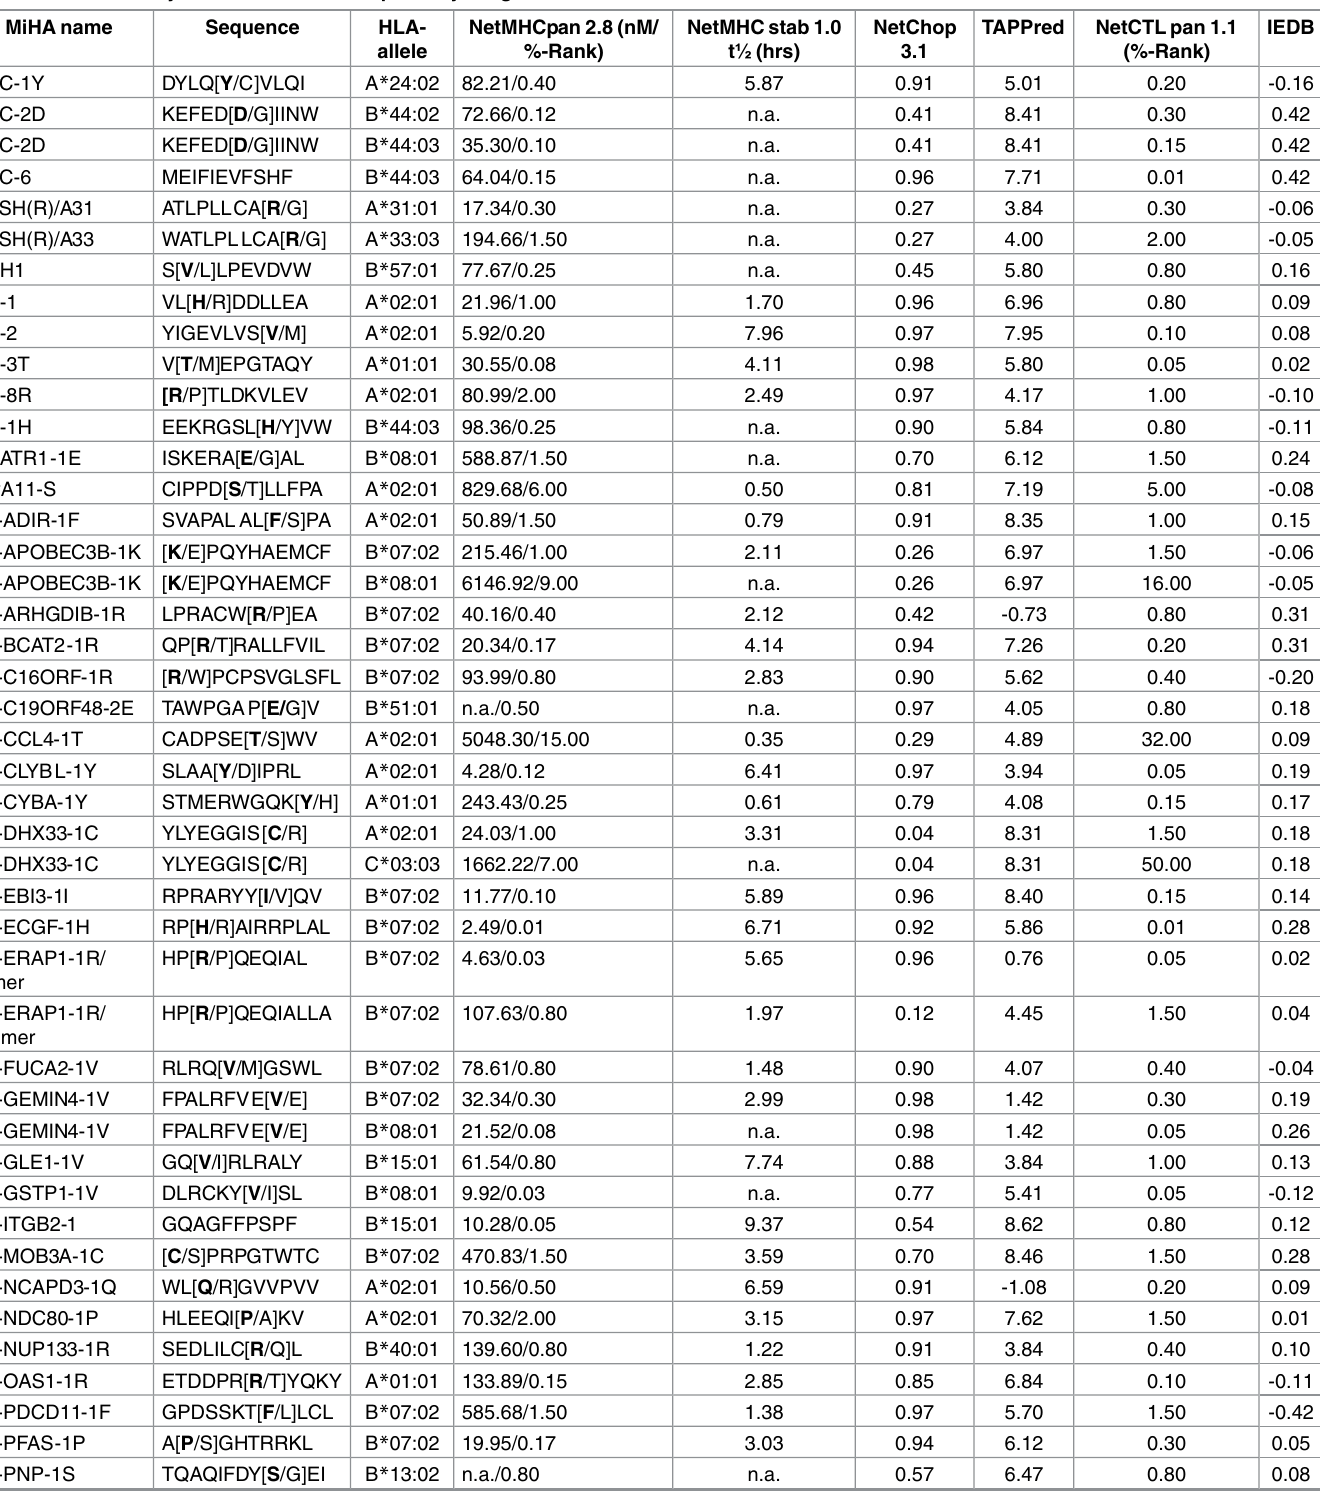
Table 2. In silico analysisof